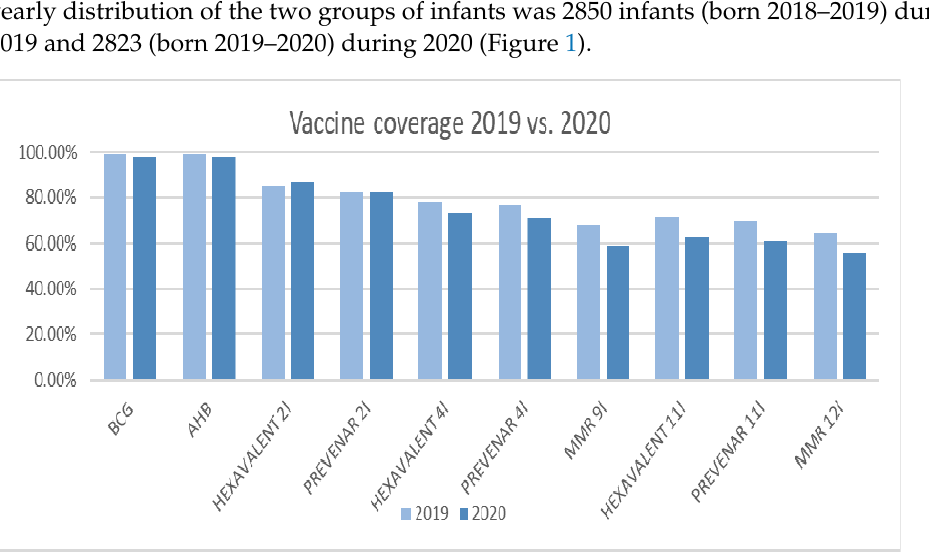
Figure 1. Vaccine coverage 2019 vs. 2020. VC was analyzed for each type of vaccine included in The National Immunization 0–12 months of age group—Vaccines included in The National Immunization Program: Calmette Guerin (tuberculosis), AHB—Hepatitis B, MMR—mumps-measles- rubella, Prevenar 13, Hexavalent—(Hepatitis B, Haemophilus influenzae type B, Diphteria-Tetanus- Pertussis-IPV Poliomyelitis).